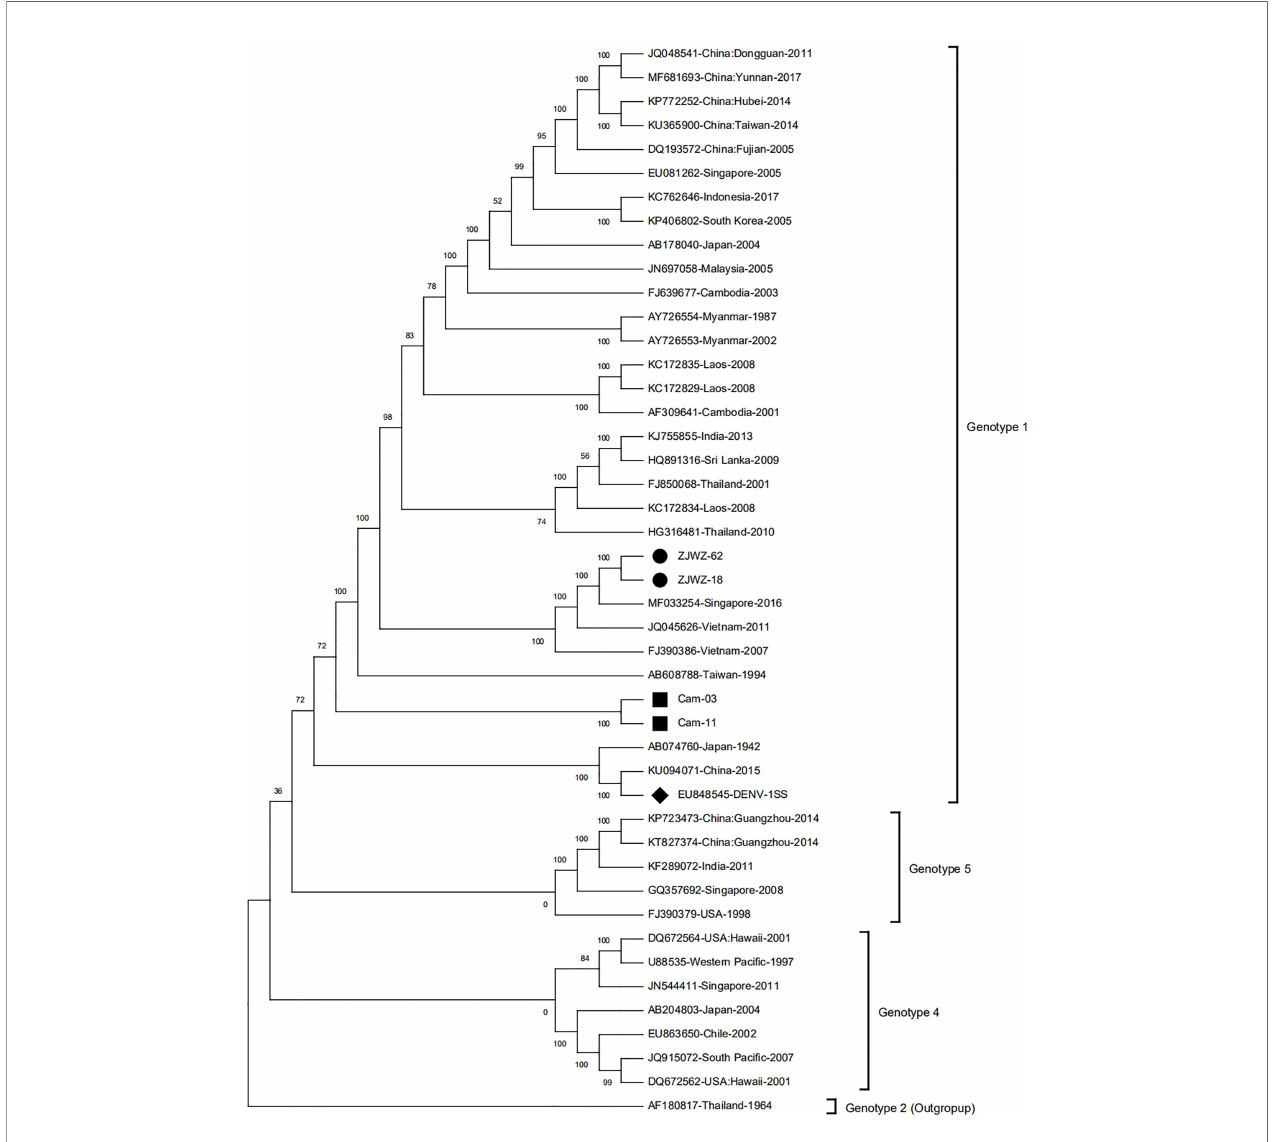
FIGURE 2 | Phylogenetic analysis based on whole genome sequence. ● represent Wenzhou local strains, ◼ represent strain with traveling Cambodia, ♦ represent standard strain